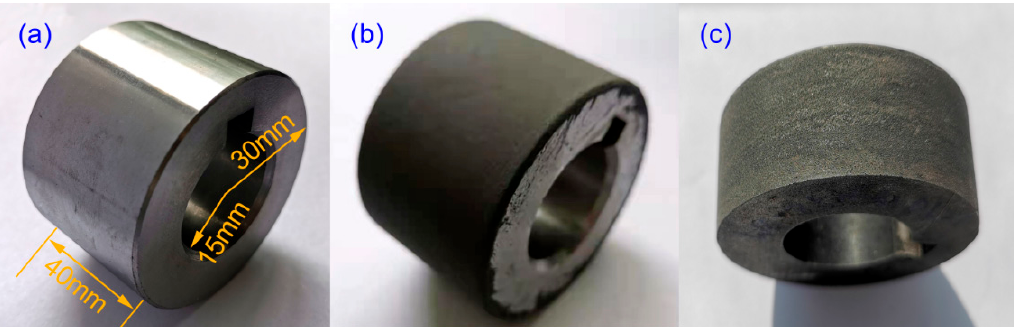
Figure 3. Schematic diagram of the ECS equipment.